Question: Judging by this figure, is the value going up or going down?
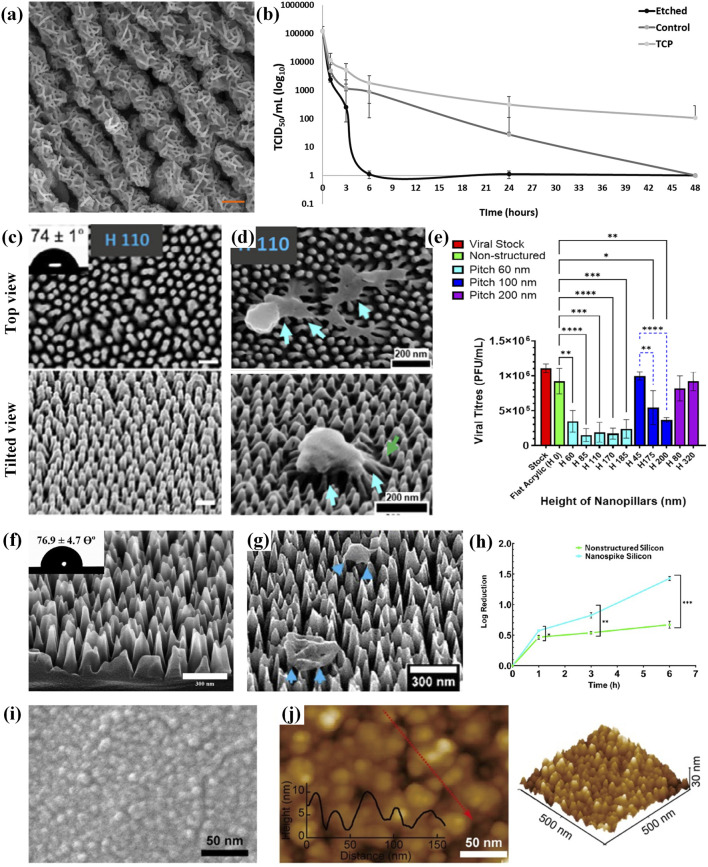
Answer: increasing